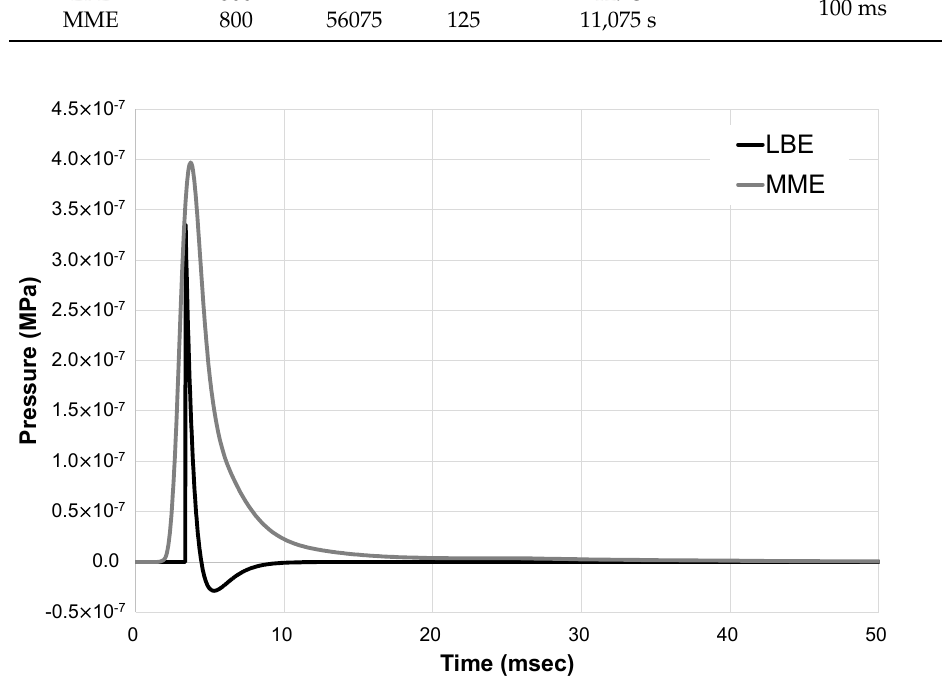
Figure 3. Comparison of pressure histories of MME and LBE.